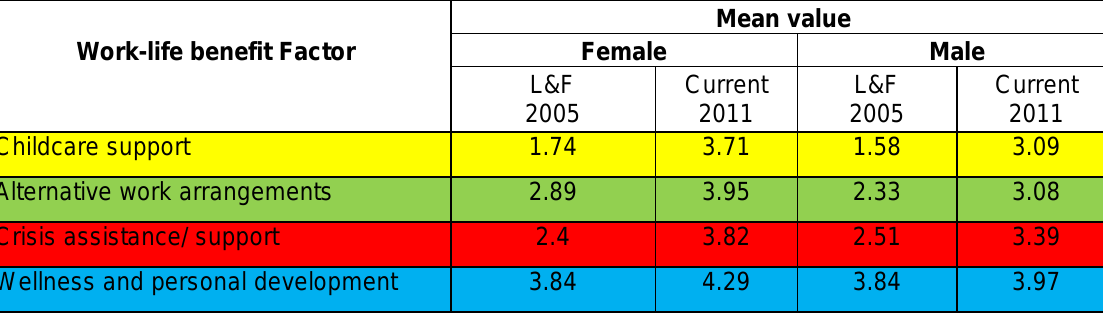
Table 5 Comparison of preferences for work-life benefit by gender (after Lingard and Francis 2005)